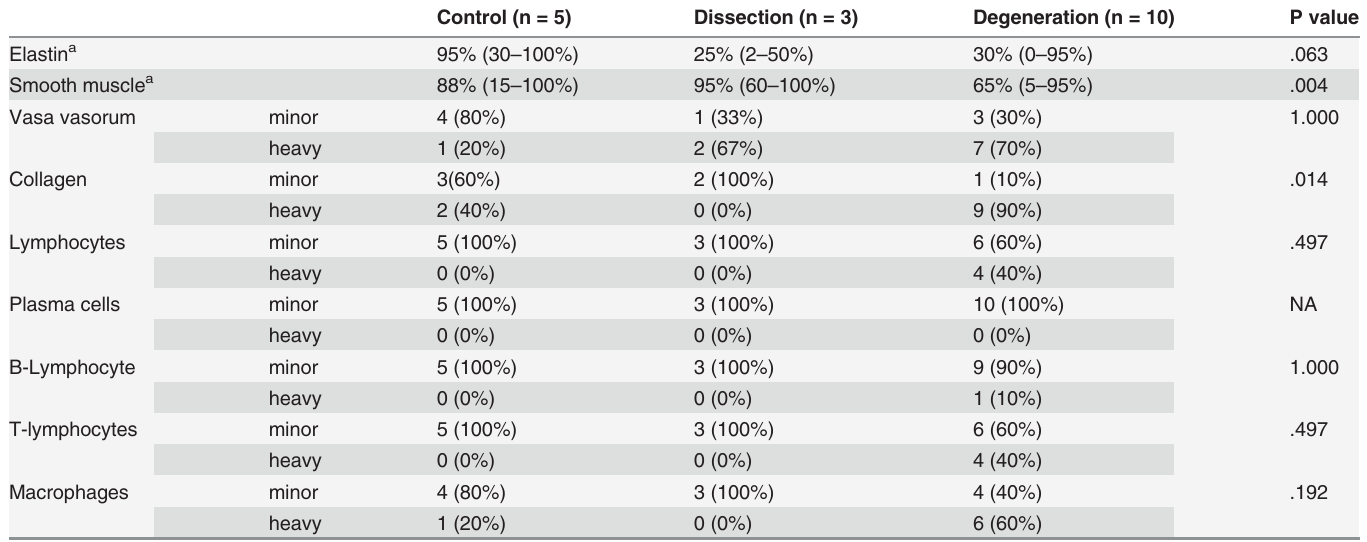
Table 3. Histology characteristics.